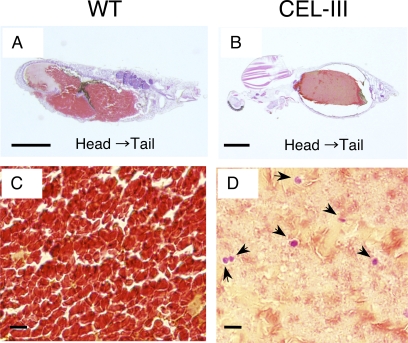
Hemolysis of Human Blood in Mosquito MidgutMosquitoes were allowed to feed on a human volunteer. Representative photomicrographs of engorged mosquito gut sections 24 h after a blood meal are shown (HE staining, ×40 magnification for [A and B], and ×1,000 magnification for [C and D]). Midgut of non-transgenic mosquitoes was filled with intact erythrocytes (A and C), with many spaces between erythrocytes. In contrast, no space is observed in the midgut of transgenic mosquitoes (B and D). Erythrocytes appear to be completely hemolyzed, and HE-stained lymphocytes cells are detectable (arrows). Scale bars in (A and B) and (C and D) are 500 μm and 10 μm, respectively.